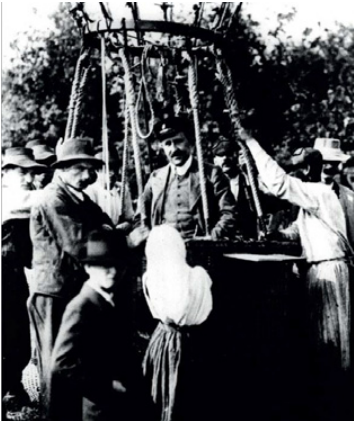
Figure 1. Hess in the basket of his balloon, sometime in